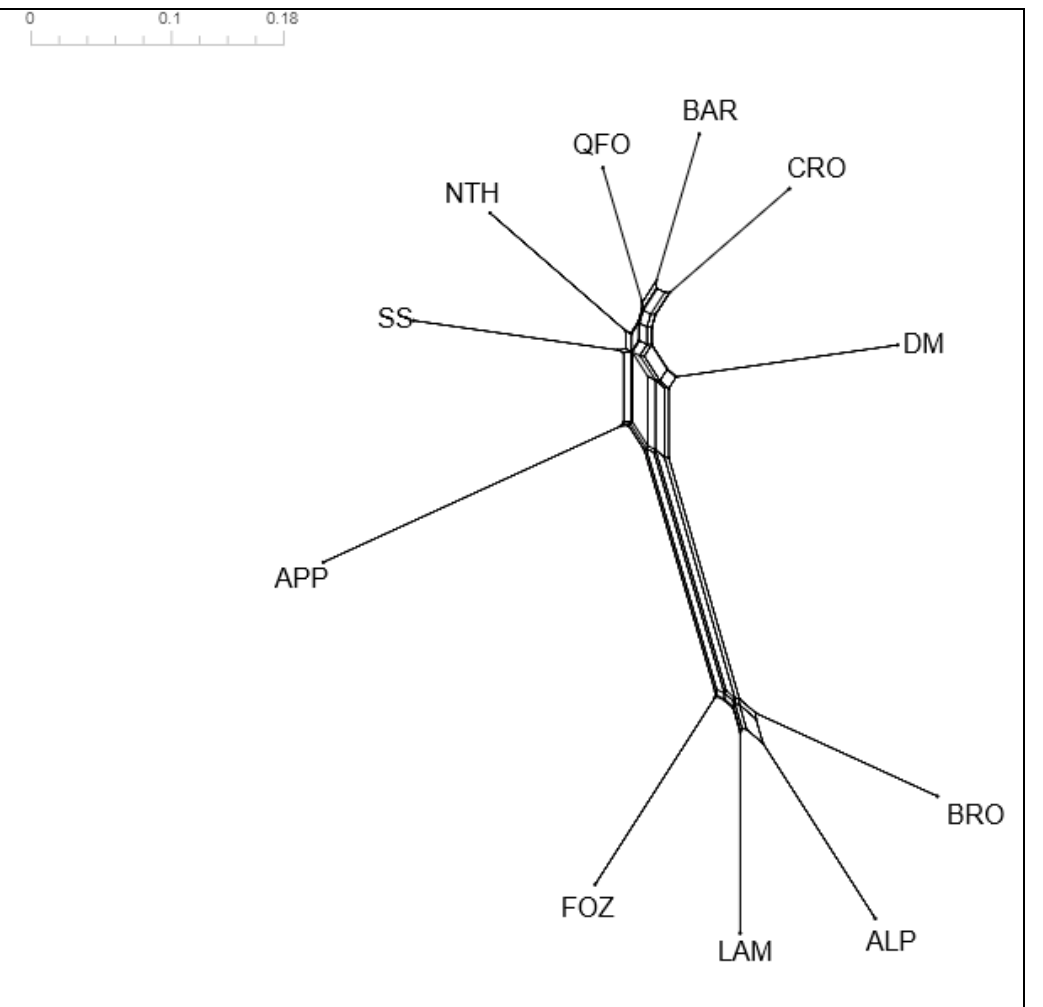
Figure 2. Neighbor network representation of the Proportion of Shared Allele (POSA) distances between the analyzed native breeds; Tunisian breeds: Barbarine (BAR), Queue Fine de l’Ouest (QFO), cross-bred BAR × QFO (CRO), D’man (DM), Sicilo-Sarde (SS), Noire de Thibar (NTH); Venetian breeds: Alpagota (ALP), Brogna (BRO), Foza (FOZ) and Lamon (LAM); Central Italian breed: Appenninica (APP).